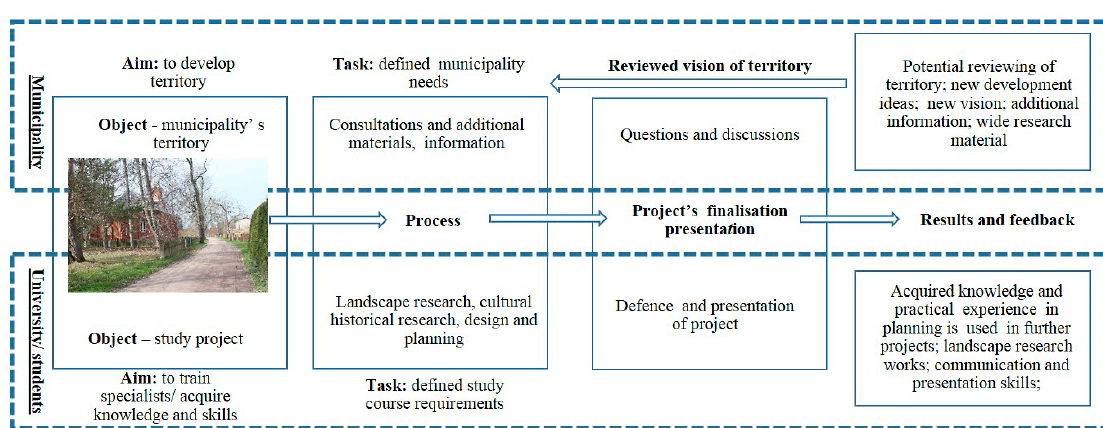
Fig. 1. The map of administrative division of Latvia (modified by authors, http://www.varam.gov.lv/lat/darbibas_veidi/pasv/)